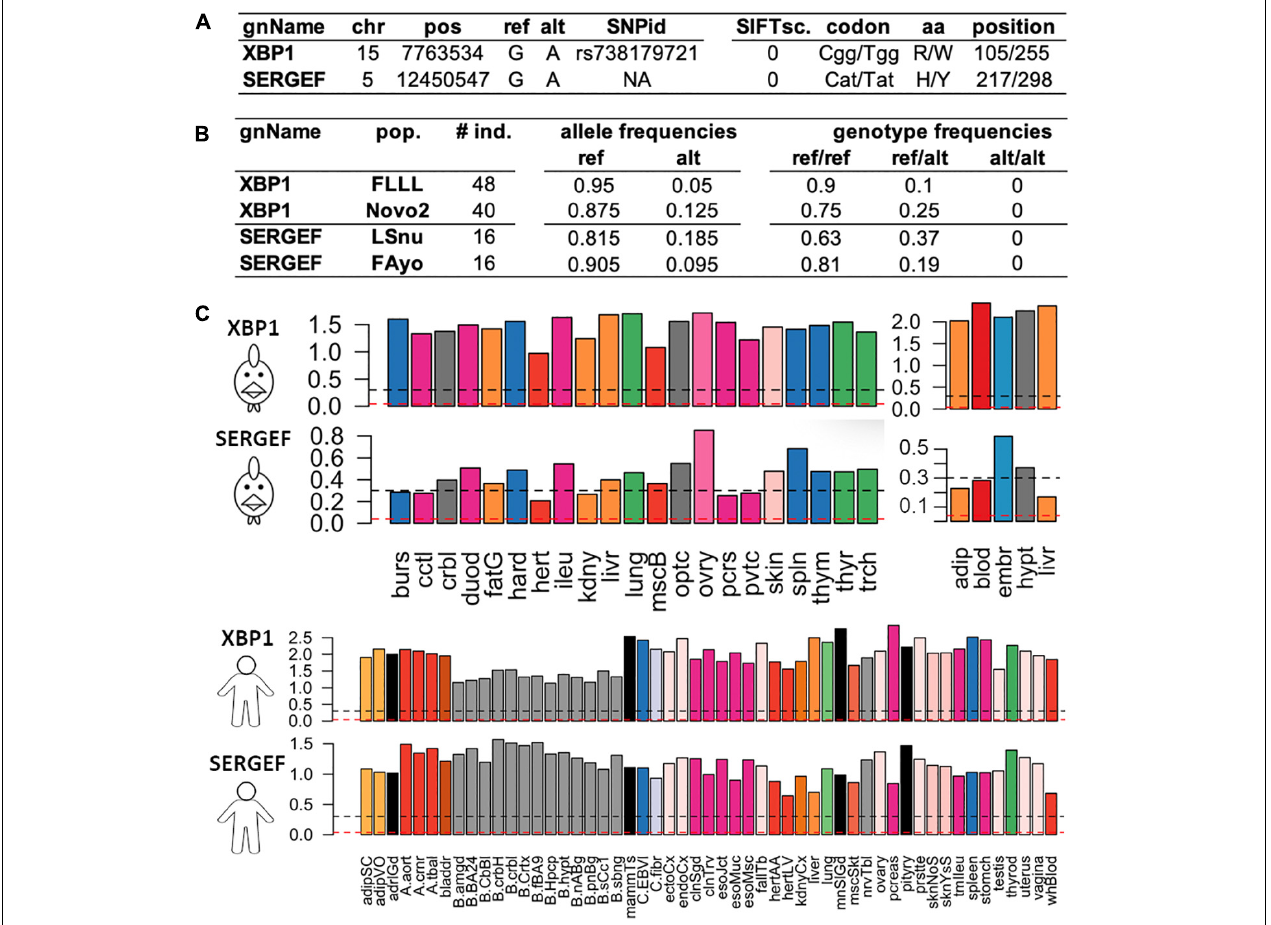
FIGURE 6 | Two examples of deleterious missense SNPs impacting two protein coding genes (XBP1 and SERGEF). (A) genomic position of the SNP with its identifier (SNPid) in Ensembl dbSNP and its impact on the protein with SIFTsc.: SIFT score, codon/modified codon, amino acid/modified amino acid and its position in the protein. (B) pop.: population with the individual size (# ind.) observed per population and the frequencies of the alleles and genotypes. (C) Tissue expressions [log10(TPM + 1)] in chicken using two datasets composed of 21 tissues (ERP014416) (left) and 5 tissues RpRm population) (right) and in human through the 53 tissues from the GTEX consortium (The GTEx Consortium, 2020). Abbreviations for the 21-tissue dataset: burs, bursa of Fabricius; cctl, cecal tonsils; crbl, cerebellum; duod, duodenum; fatG adipose tissue around the gizzard; hard, harderial gland; hert, heart; ileu, ileum; kdny, kidney; livr, liver; lung, lung; mscB breast muscle; optc, optical lobe; ovry, ovary; pcrs, pancreas; pvtc, proventriculus; skin, skin; spln, spleen; thym, thymus; thyr, thyroid gland; trch, trachea; and for the 5-tissue dataset: adip, abdominal adipose tissue; blod, blood; embr, 4.5 day embryos; hypt, hypothalamus; livr, liver; for more details in these 3 datasets and associated samples see Jehl et al. (2020). Black dashed line: gene expression with TPM ≥ 1 and red dashed line: TPM ≥